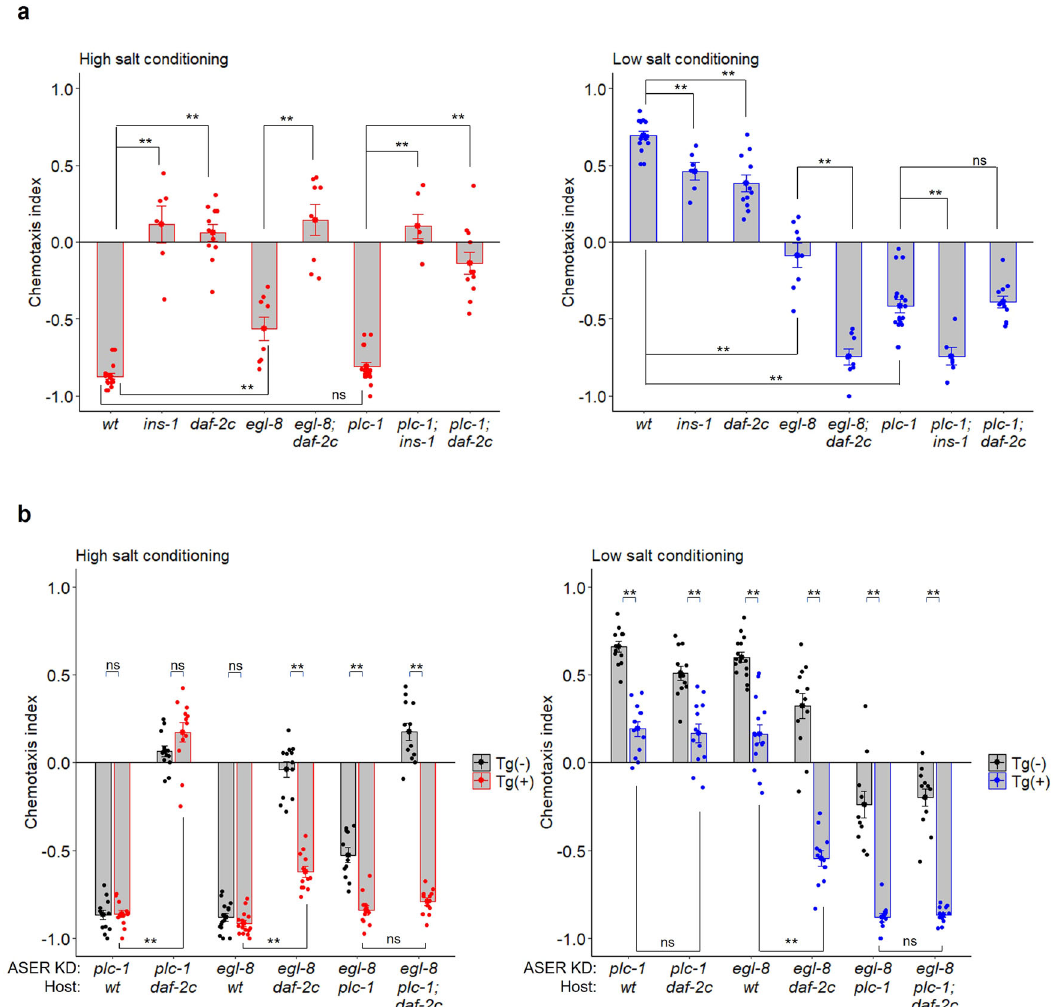
Fig. 5 The DAF-2c pathway promotes taste avoidance learning via the PLC isozymes PLC-1 and EGL-8. a Salt chemotaxis after conditioning on agar plates at high or low salt concentrations in the absence of food. Each dot in red or blue represents a chemotaxis index calculated in each chemotaxis assay after conditioning at high or low salt concentrations, respectively. n = 6 – 17 assays. b Effects of ASER-speci fi c knockdown of plc-1 or egl-8 on salt chemotaxis in the indicated genetic backgrounds. Salt chemotaxis after conditioning on agar plates at high or low salt concentrations in the absence of food using worms expressing Cas9 in ASER and sgRNA with a target sequence of plc-1 or egl-8 . Each dot in red or blue represents a value calculated in each chemotaxis assay after conditioning at high or low salt concentrations, respectively. A black dot represents a chemotaxis index calculated in each chemotaxis assay using worms without transgenes. n = 11 – 15 assays. Bars represent mean values; error bars represent SEM. Two-tailed Welch ’ s t-test with Holm correction: ** P < 0.01. ns not signi fi